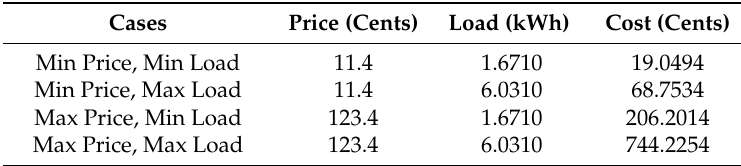
Table 15. Possible cases: OTI 60-min using